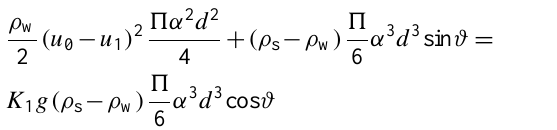
/d , against Θ/Θ , estimated with different s cr